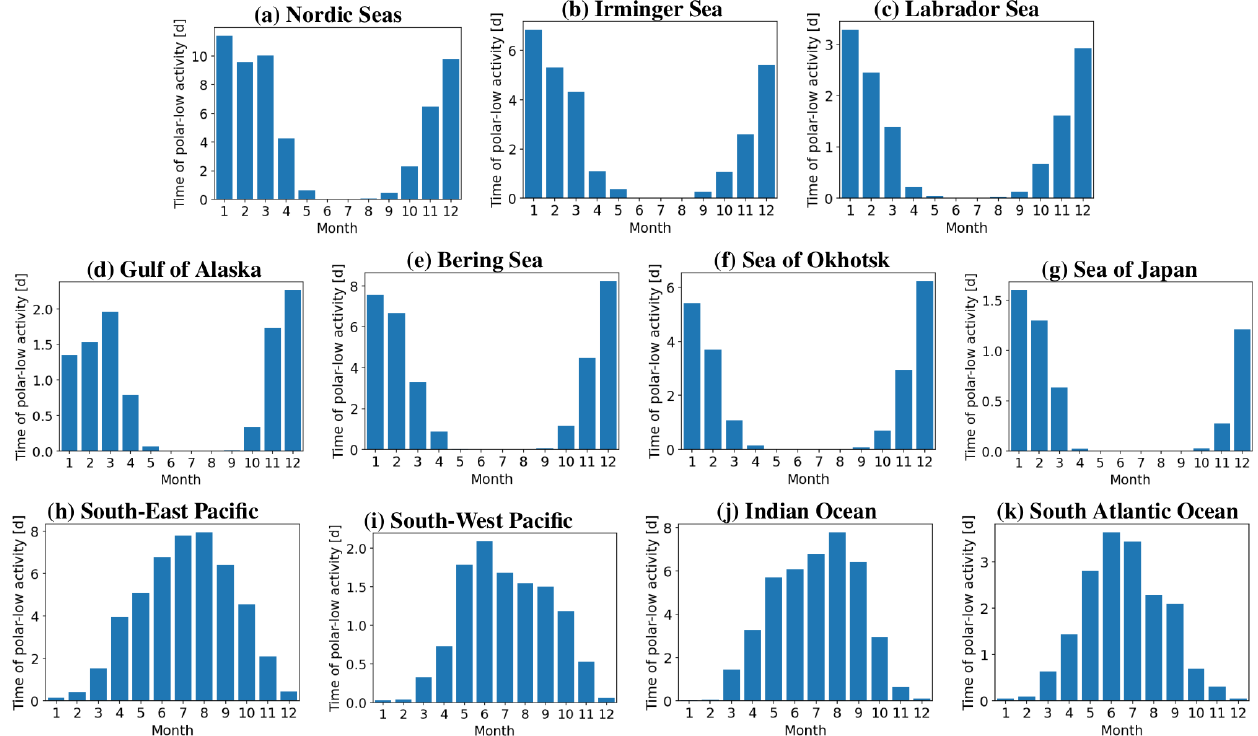
Figure 5. The average monthly time of polar-low activity normalized to months with a duration of 30d for the specific regions marked by boxes in Fig.